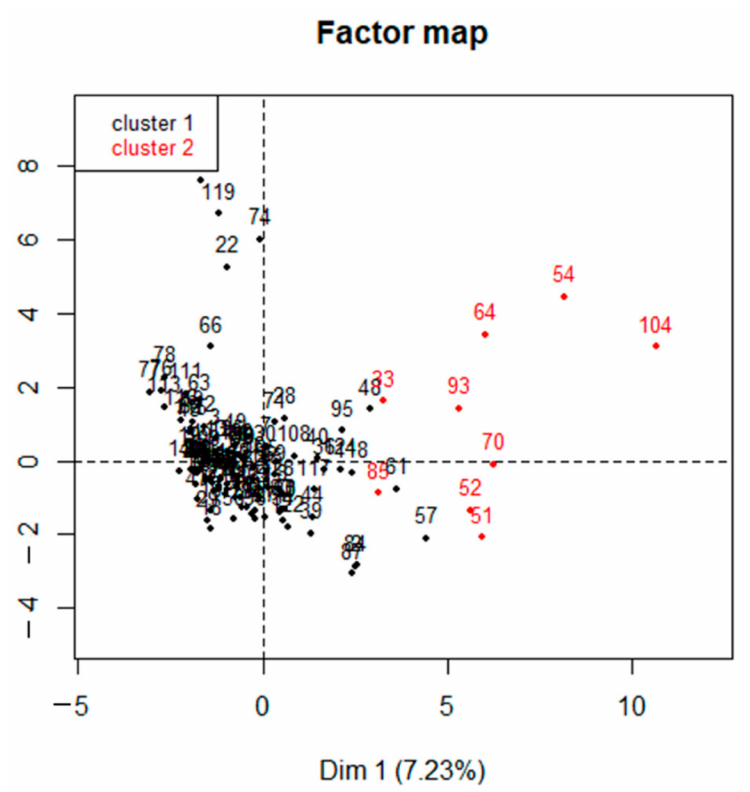
Figure 6. Representation of the two clusters identified using the results of the multiple factor and hierarchical clustering analyses of the 113 survey responses from conventional dairies in CA during